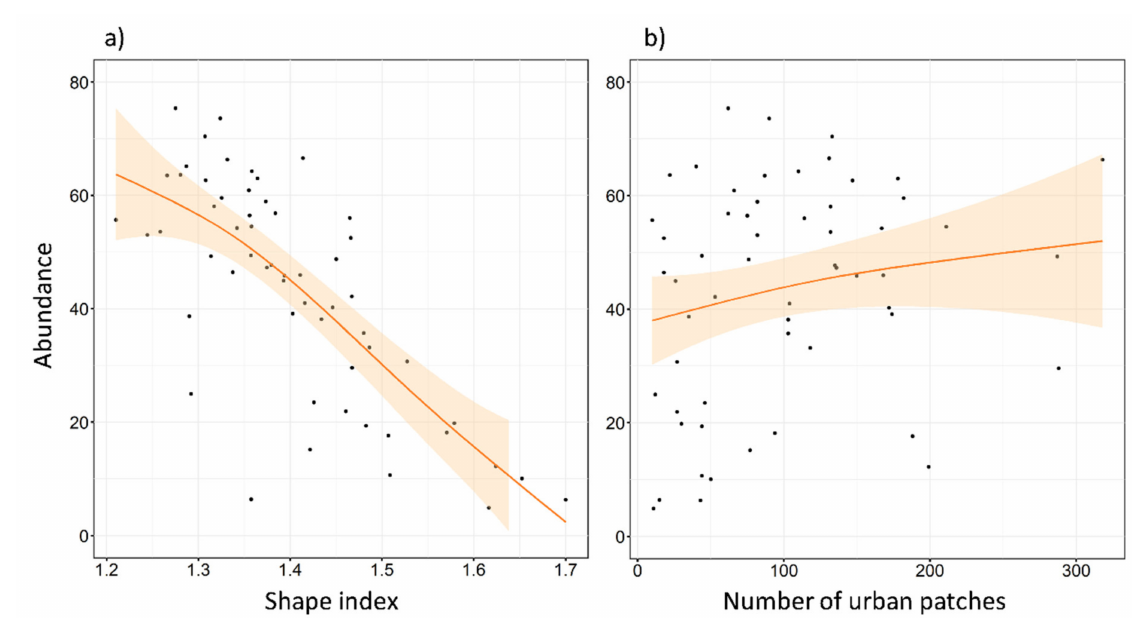
Figure 6. Expected tawny owl ( Strix aluco ) abundance at the landscape scale, based on the top-ranked model with respect to ( a ) different shape index of urban patches, and ( b ) the number of urban patches. The shape index represents the degree of irregularity of habitat patches (in our case, urban habitat). It is equal to 1 when the urban patch is maximally compact (almost square) and increases without limit as the patch shape becomes more irregular. The orange lines show a cubic smoothing spline fitted to the data to show the general trend, while shaded areas show standard error